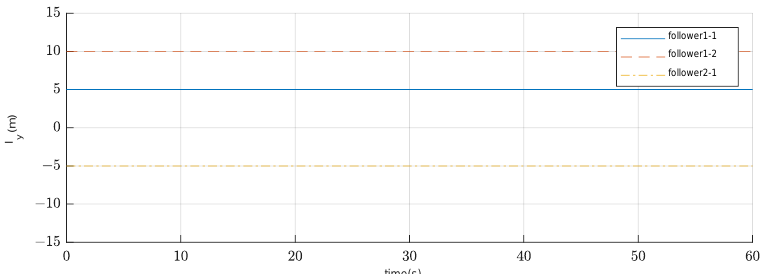
Figure 31. The variation curves of l y for each follower during the movement. Follower 1-1 indicates the position of follower No.1 in sub-fleet No.1, and follower 2-1 indicates the position of follower No.1 in sub-fleet No.2.